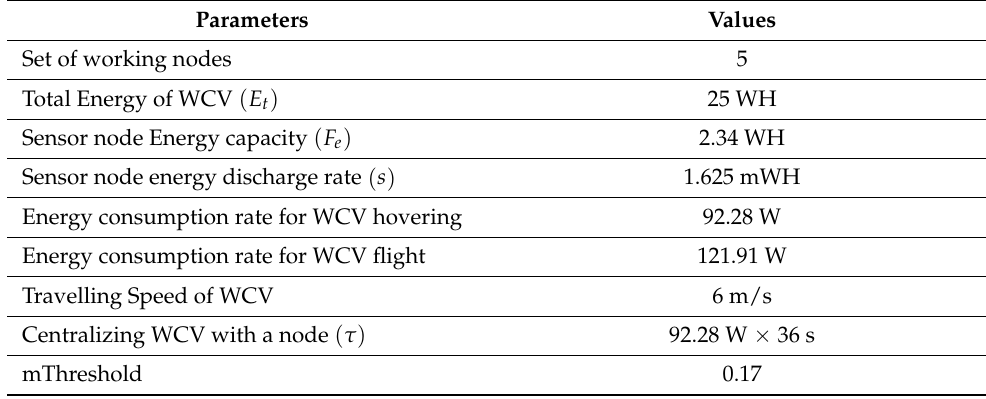
Table 2. Simulation Parameters.